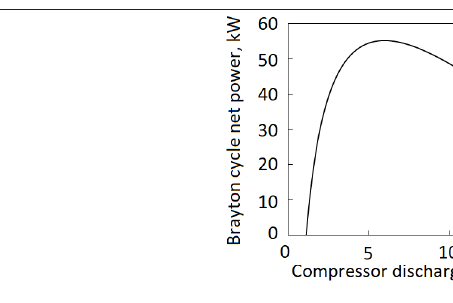
Figure 6. Net power generated in Brayton cycle as a function of compressor discharge pressure.